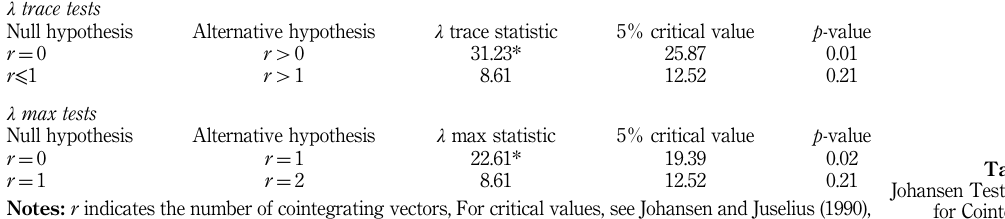
Table VI. Johansen Test Results